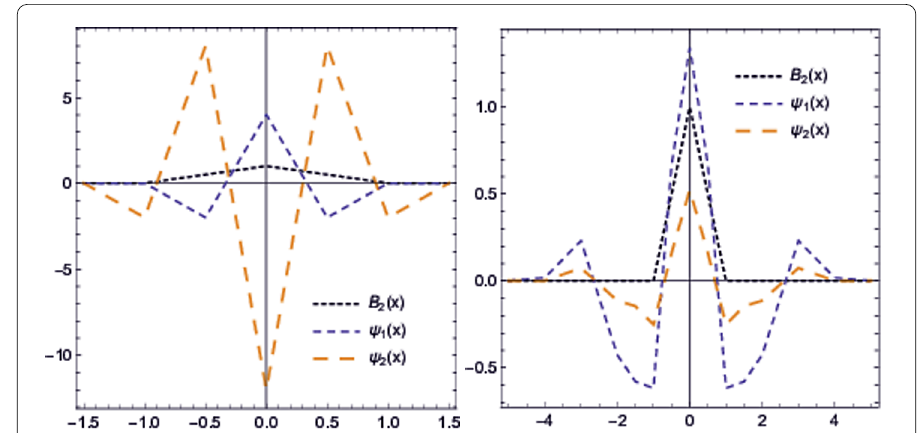
Figure 1 The graphs of the functions in X ( (cid:7) 1 ) for Examples 2.1 and 2.2,